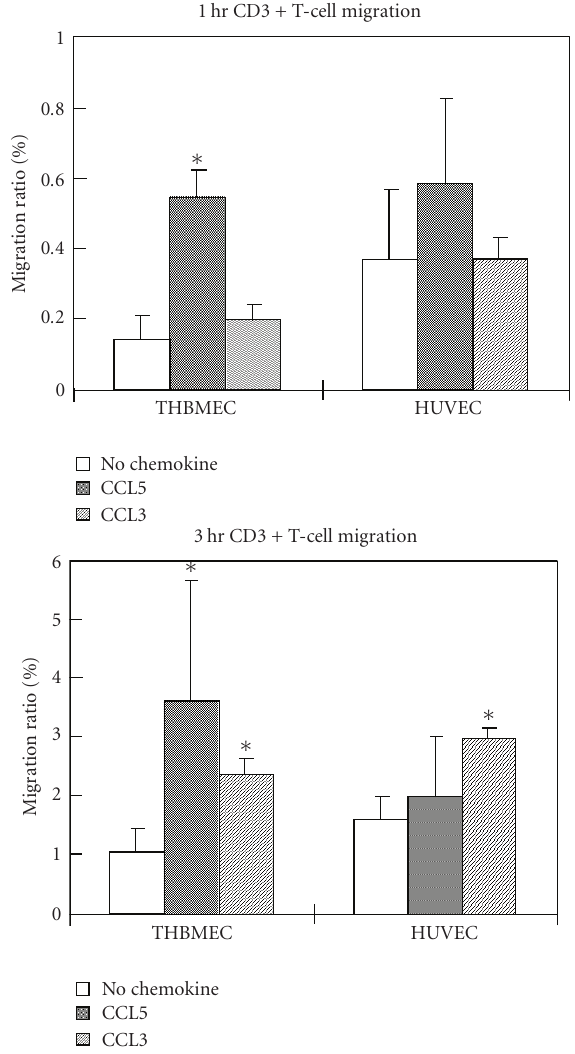
Figure 4: THBMEC cultures utilize both CCL3 and CCL5 to drive T cell migration while HUVEC cultures utilize CCL3 only. THBMECs or HUVECs were cultured to confluence on Transwell TM inserts. 10 6 of PBMCs from the same donor were added into the inserts with or without 50 ng/mL CCL3 or 100 ng/mL CCL5 added to the lower chamber (well). Migration ratios were calculated as described in Section 2. CCL3 facilitated T cell migration across both THB- MECs and HUVECs while CCL5 induced T cell migration across THBMECs only. The assays were performed in quadruplicate for each donor and three donors were included. ∗ indicates P < .05 com- pared to basal migration without added chemokine.